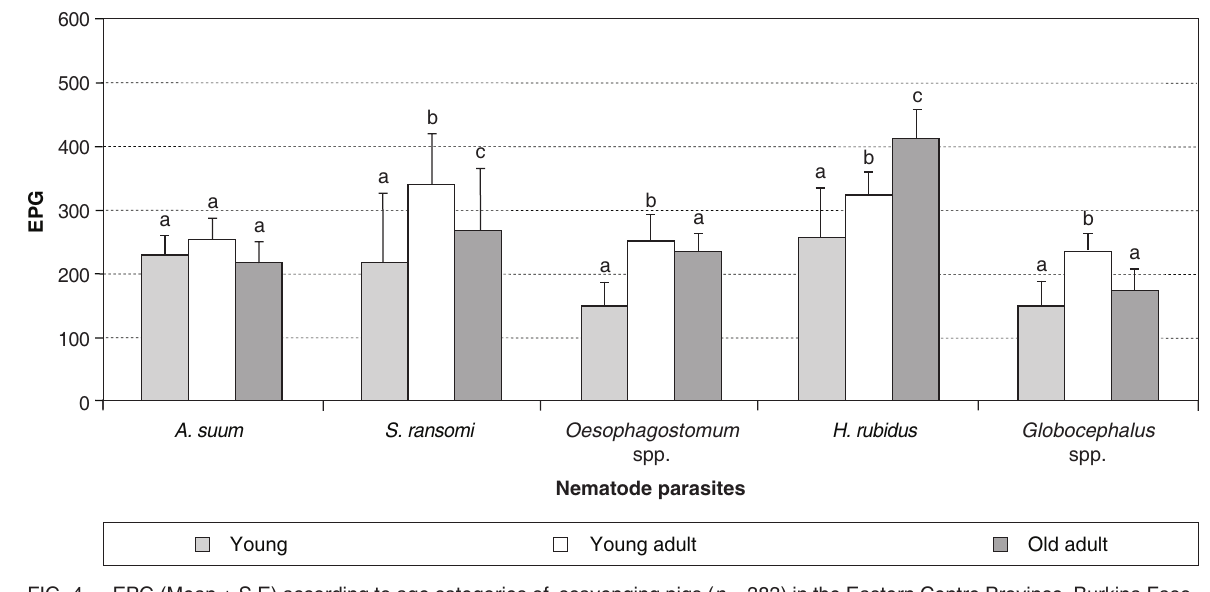
FIG. 4 EPG (Mean ± S.E) according to age categories of scavenging pigs ( n = 383) in the Eastern Centre Province, Burkina Faso. For each nematode parasite species, two means that are not followed by the same subscript letter are significantly different ( P < 0.05). No comparison was done as regards to T. suis infected pigs; only females ( n = 3) presented the same value